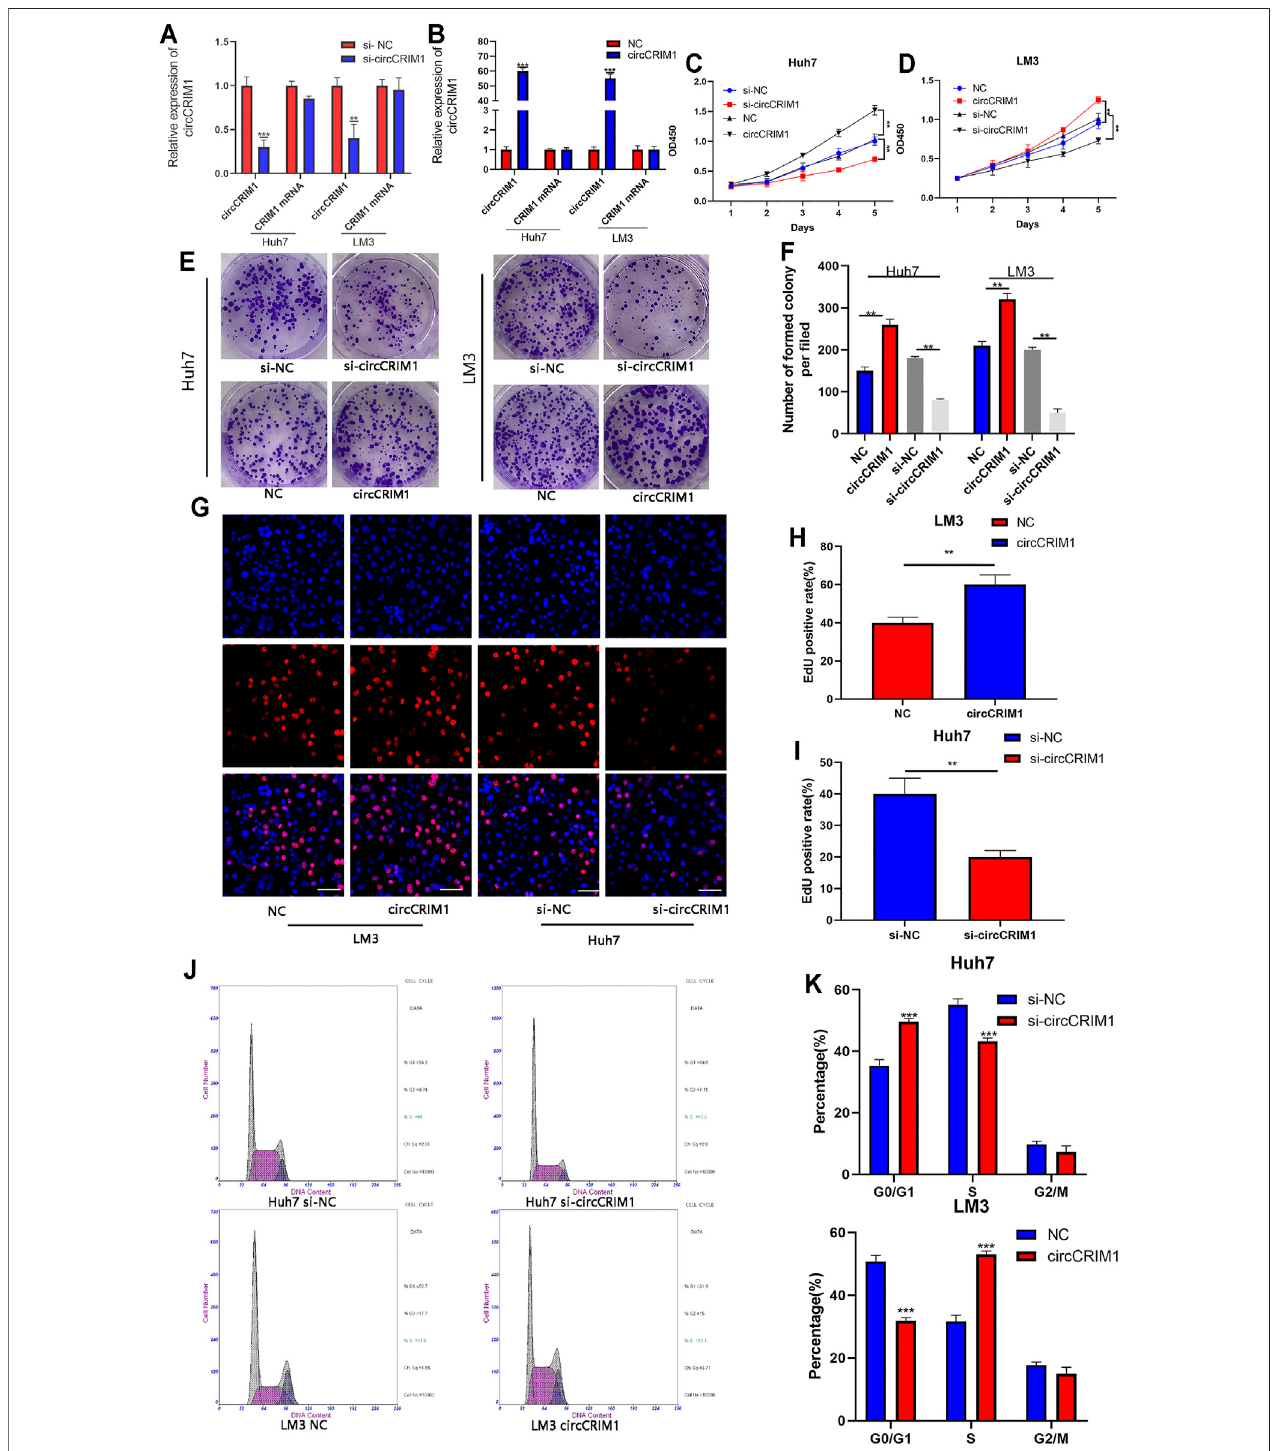
FIGURE 2 | CircCRIM1 promotes the proliferation of HCC cells and accelerates the transition from G1 to S phase. (A,B) QRT-PCR analysis of circCRIM1 and CRIM1 mRNA expression in LM3 and Huh7 cells transfected with si-NC, si-circCRIM1, circCRIM1, and NC. (C,D) Cellular growth curves were evaluated by CCK-8 assays after knocking down or overexpressing circCRIM1 in LM3 or Huh7 cells. (E,F) Colony formation assays were performed to evaluate cell proliferation. (G – I) EdU assayswere performed on HCC cells to evaluate cell proliferation. Scale bar, 50 μ m. (J,K) Flow cytometry assays show that circCRIM1 canaccelerate the G1 toS phase cell cycle transition, while circCRIM1 knockdown increases the percentage of G1 phase cells. All data are presented as the means ± SD of three independent experiments. * p < 0.05, ** p < 0.01, and *** p < 0.001.